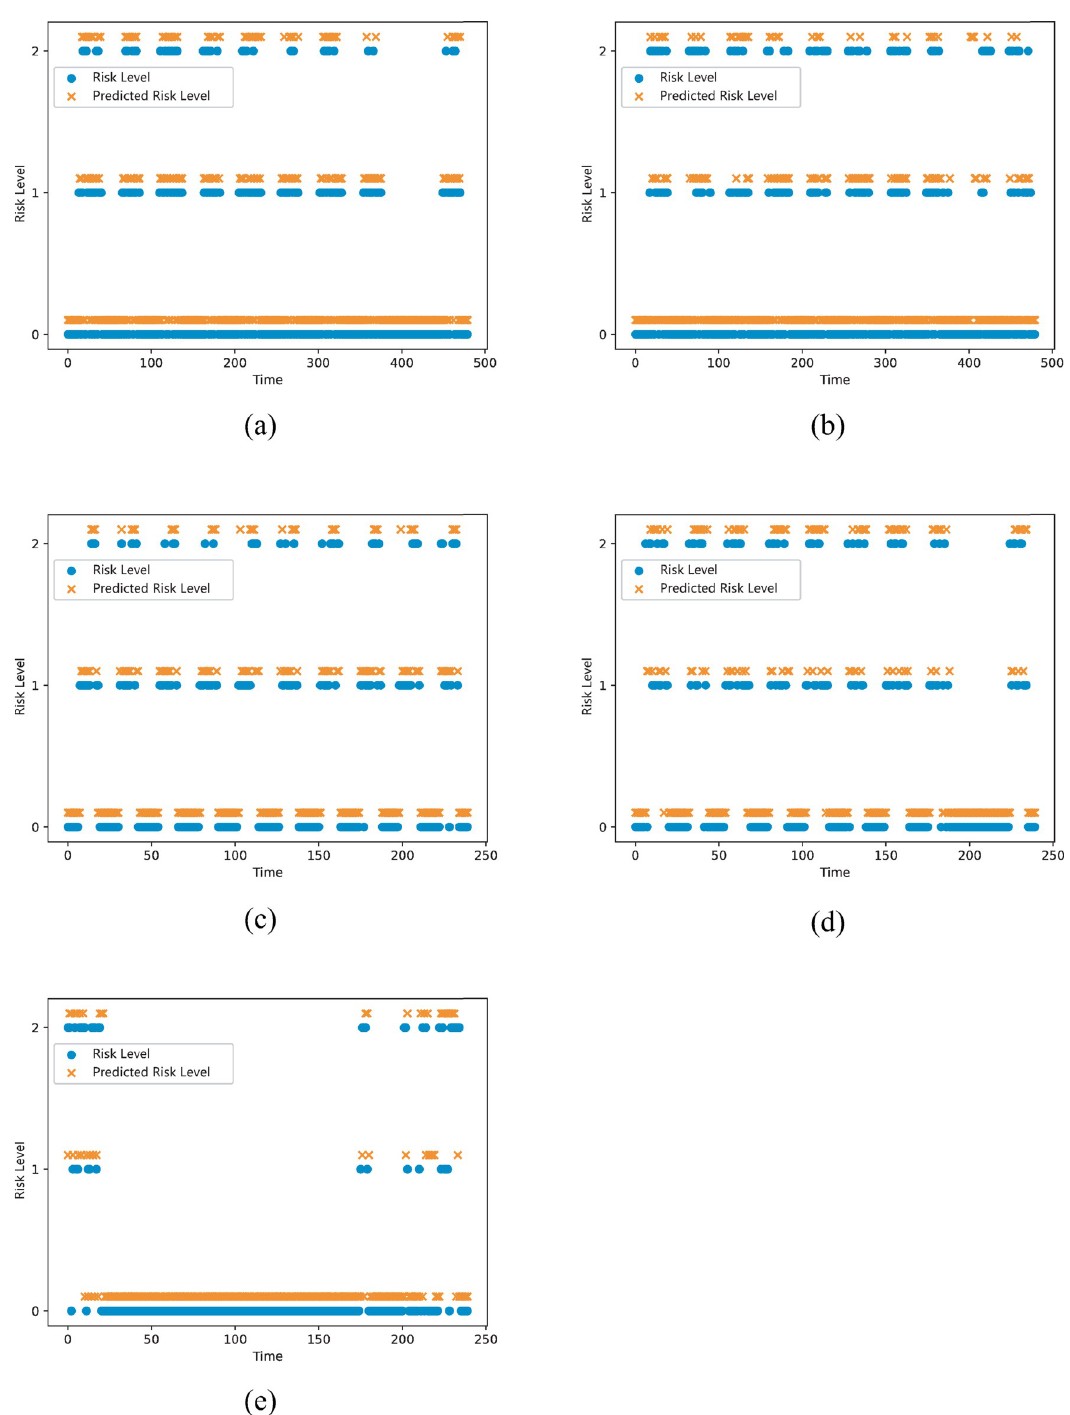
Fig 6. The prediction result of the risk level. (a) Vehicle ID 6096. (b) Vehicle ID 21973. (c) Area ID (53,24). (d) Area ID (53,23). (e) Category 104 of Vehicle ID